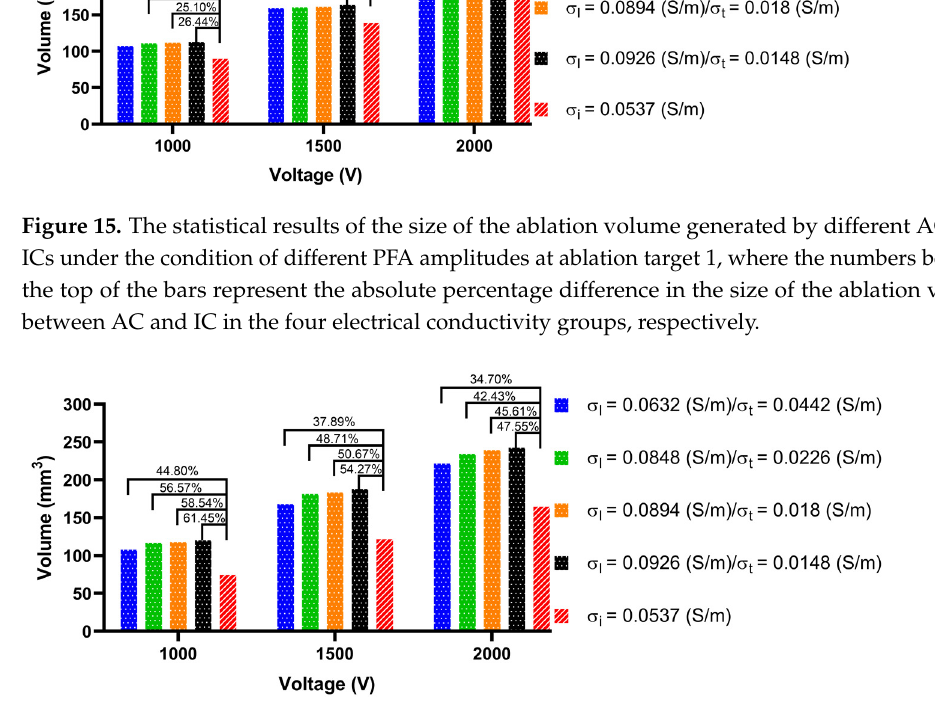
Figure 15. The statistical results of the size of the ablation volume generated by different ACs and ICs under the condition of different PFA amplitudes at ablation target 1, where the numbers be- tween the top of the bars represent the absolute percentage difference in the size of the ablation volume between AC and IC in the four electrical conductivity groups, respectively.